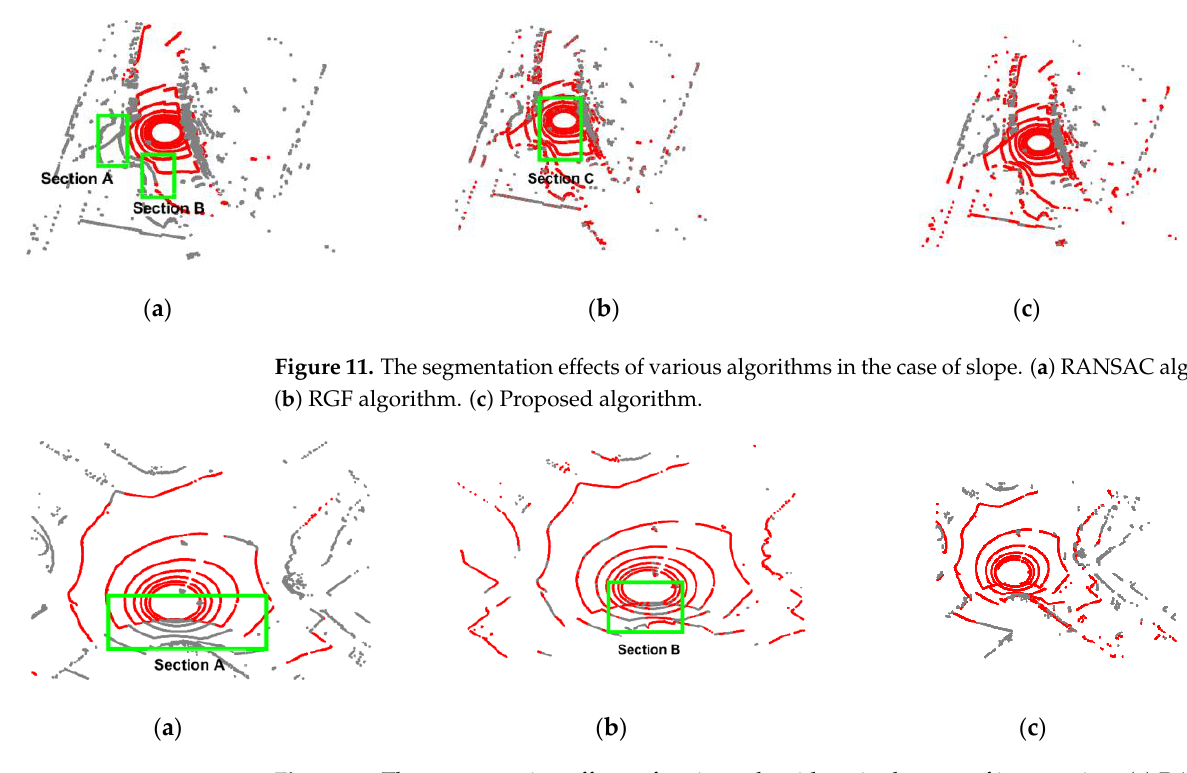
Table 3. Statistics of ground points and non-ground points in Figure